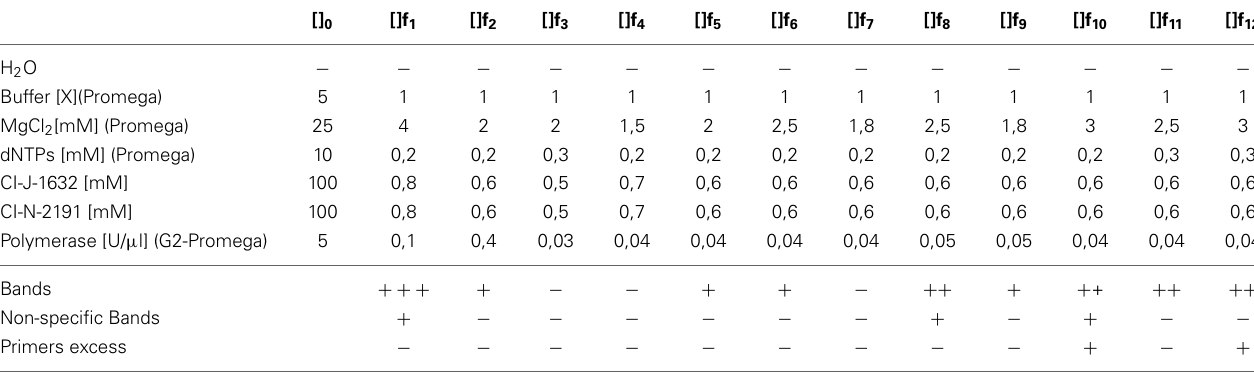
Table 3 | Final concentrations of the different master mixes tested and qualitative results obtained for samples Cochliomyia spp., collected in Pichincha—Ecuador.